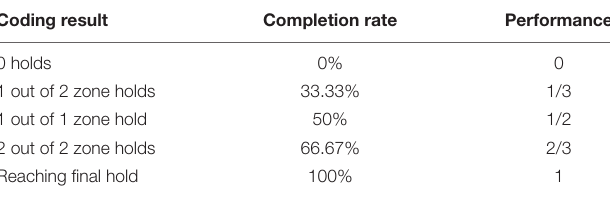
TABLE 1 | Possible scoring outcomes for performance for a given